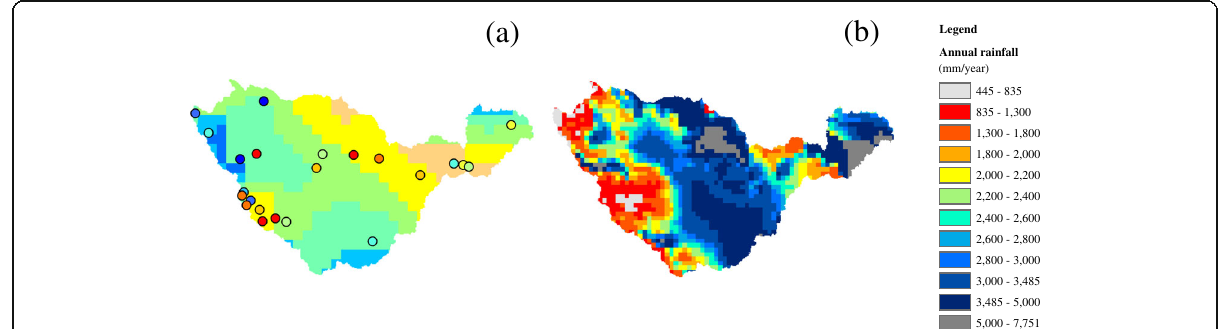
Fig. 2 Comparison of average annual rainfall maps. a GSMaP with gauged rainfall (2001 – 2013) and b NHRCM (1980 –